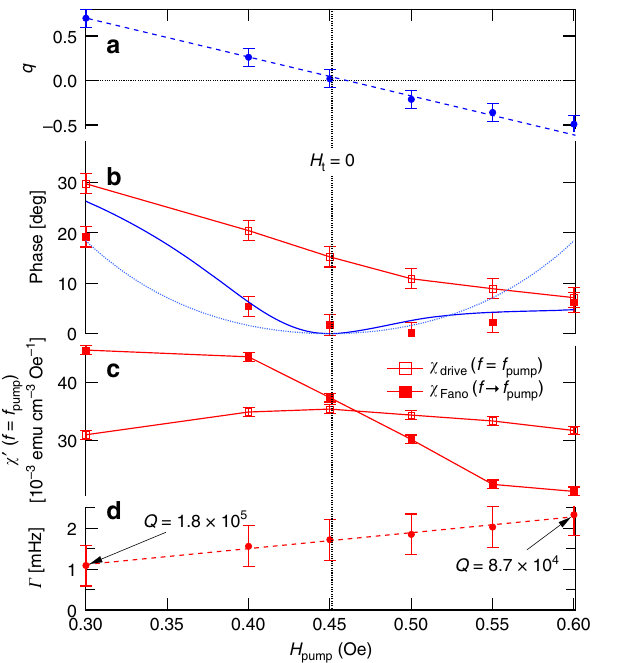
Fig. 6 Evolution of resonant behavior vs. transverse fi eld at T = 0.11 K for a 202 Hz/0.3 Oe pump. a Fano parameter q vs. transverse fi eld showing a continuous evolution including a smooth crossing through zero. Dashed line is a guide to the eye. b Evolution of the phase of the complex susceptibility at f = f pump for the nonlinear (open symbols) and linear ( fi lled symbols) responses. As with the h pump dependence shown in Fig. 5, the zero crossing of q is associated with a vanishing of the dissipation in the linear response with the same functional form, demonstrating universal behavior from two disparate tuning parameters. Blue curves follow from Eqs. 2 and 3 in text as for Fig. 5b. c Real susceptibility χ ’ measured directly at f = f pump (open symbols) and determined by extrapolating the fi tted Fano resonance to f = f fi lled symbols), showing a small but apparent distinction in the pump ( evolution of the nonlinear and linear responses. d Fano linewidth Γ vs. transverse fi eld. In contrast to the behavior as a function of h pump , increasing H t does not change the linewidth. All error bars are